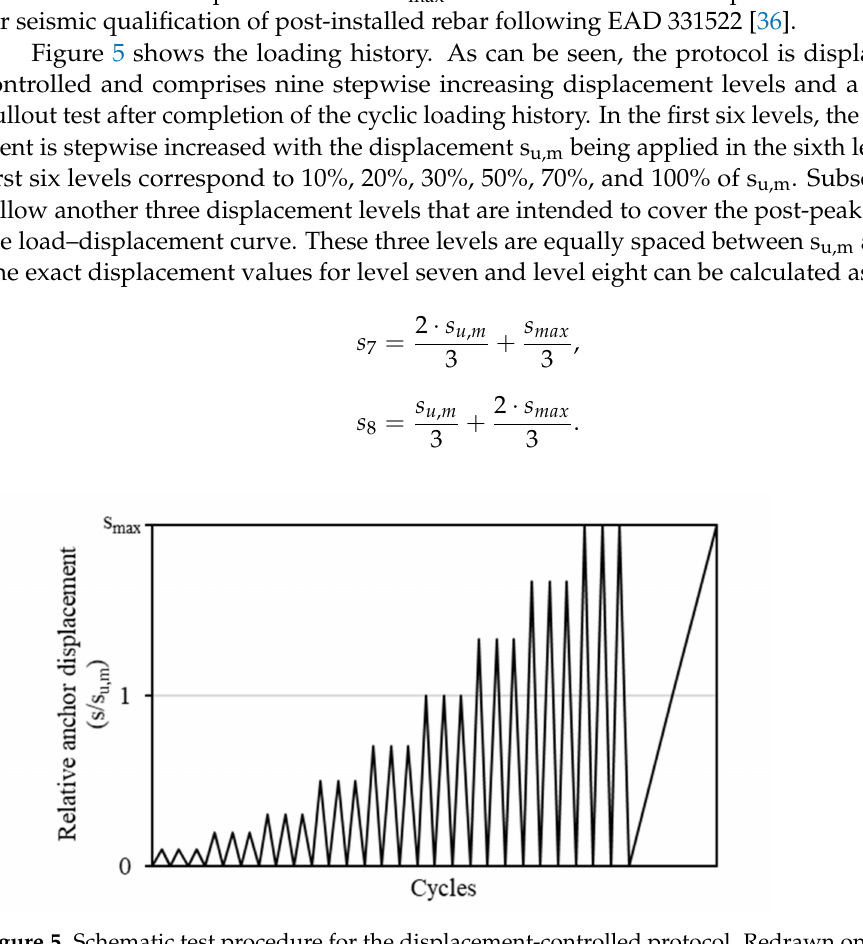
Figure 5. Schematic test procedure for the displacement-controlled protocol. Redrawn on the basis of